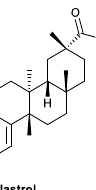
rascens Y.C. Yang ( Oleaceae ) inhibit H1N1 in vitro and in vivo. In splenocytes, treatment